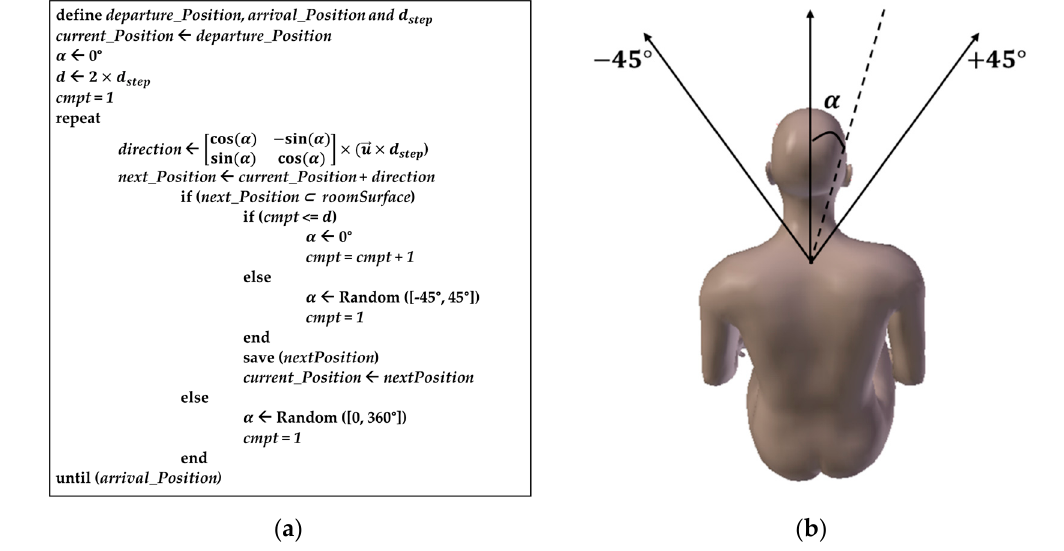
Figure 5. RW trajectory: ( a ) RW trajectory generation algorithm; ( b ) rotation angle for direction change.